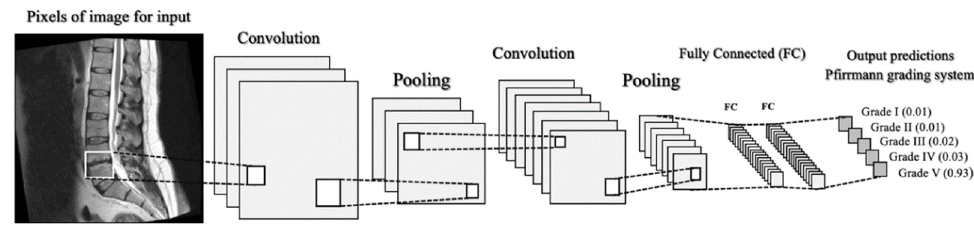
Figure 3. Deep learning architecture model used convolutional neural network (CNN).